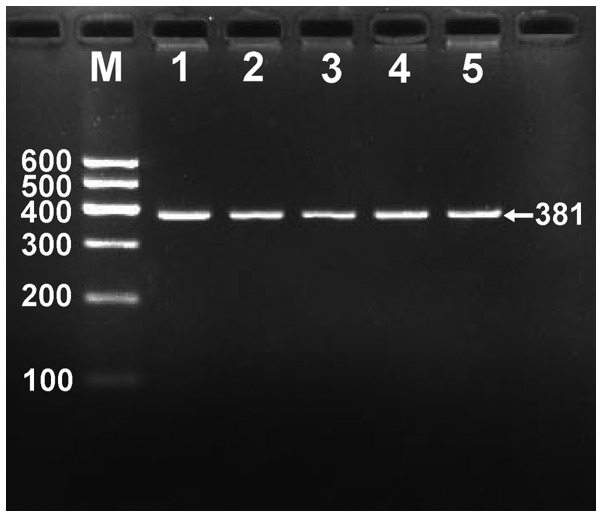
Electrophoresis of PCR products of the PABPC4 rs4660293 single nucleotide polymorphism. Lanes: M, 100 bp marker ladder; 1–6, PCR products (381 bp). PCR, polymerase chain reaction.